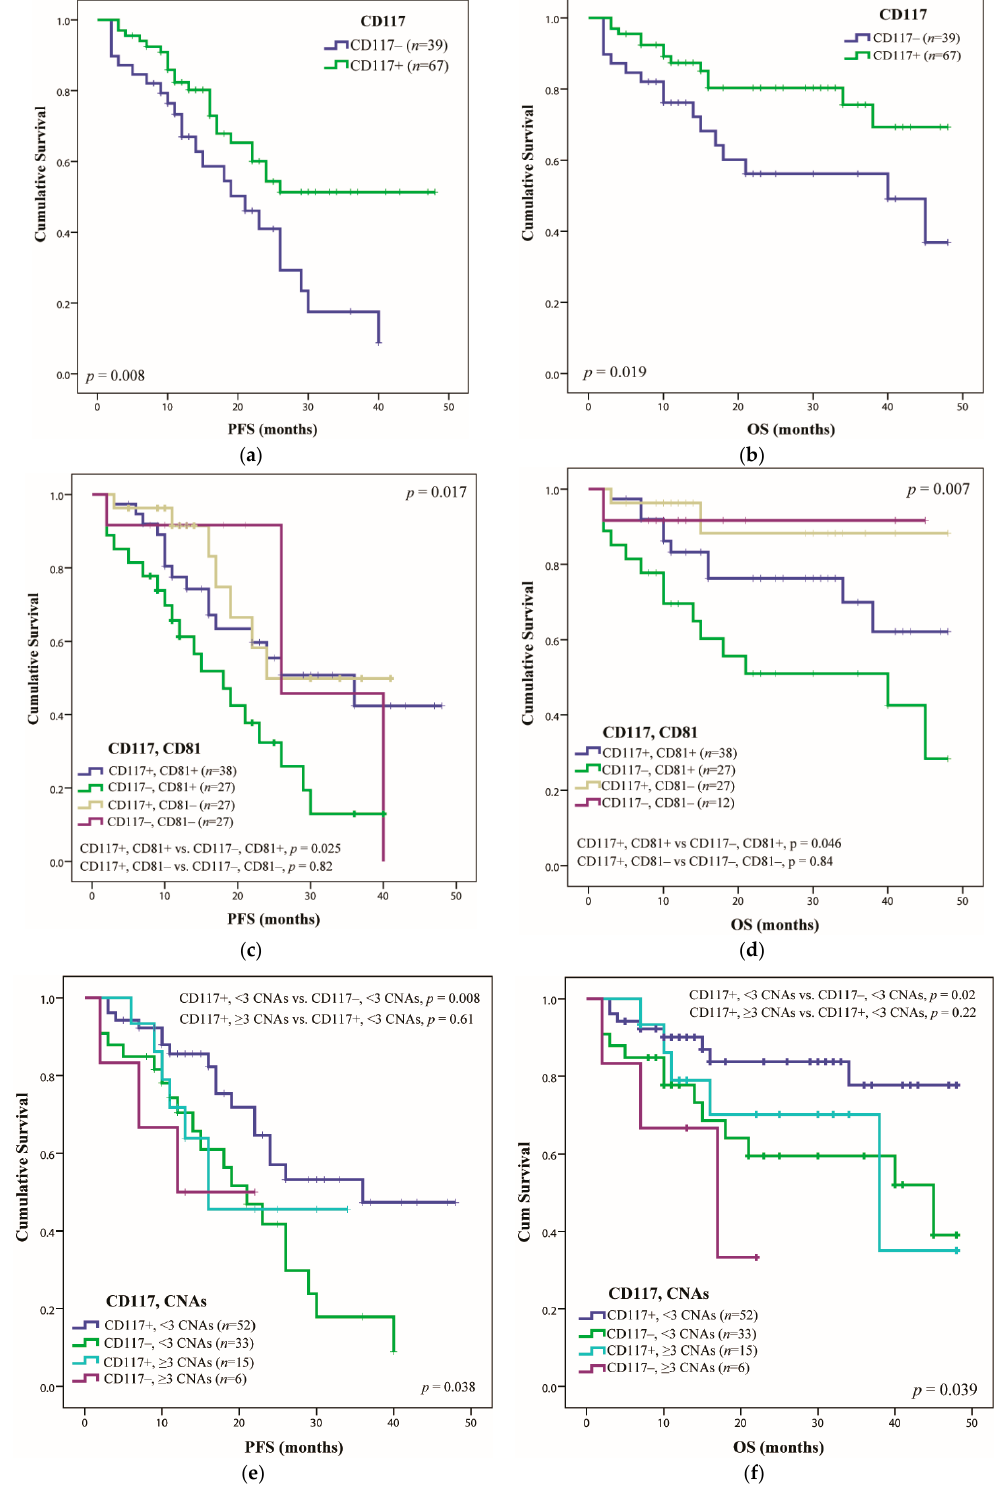
Figure 3. Multiple myeloma patients’ survival rate, taking into account the expression of CD117 marker, by Kaplan–Meier estimates: ( a ) PFS and ( b ) OS of MM patients that expressed CD117 compared with patients who do not express this marker; ( c ) PFS and ( d ) OS for patients who expressed CD117 correlated with the presence or absence of the CD81 marker; ( e ) PFS and ( f ) OS for the correlation of CD117 with adverse CNAs.